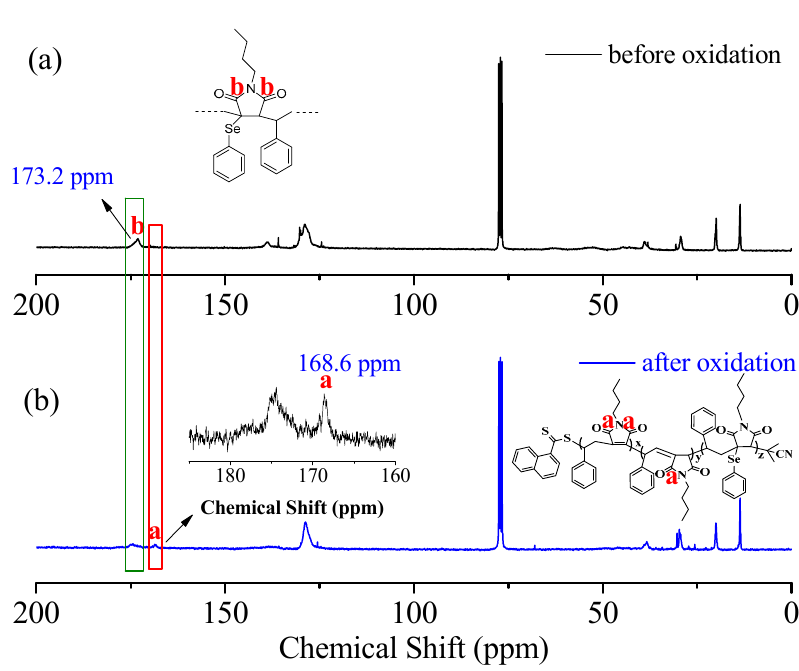
Figure 6. 13 C NMR spectrum of the oxidized copolymer.